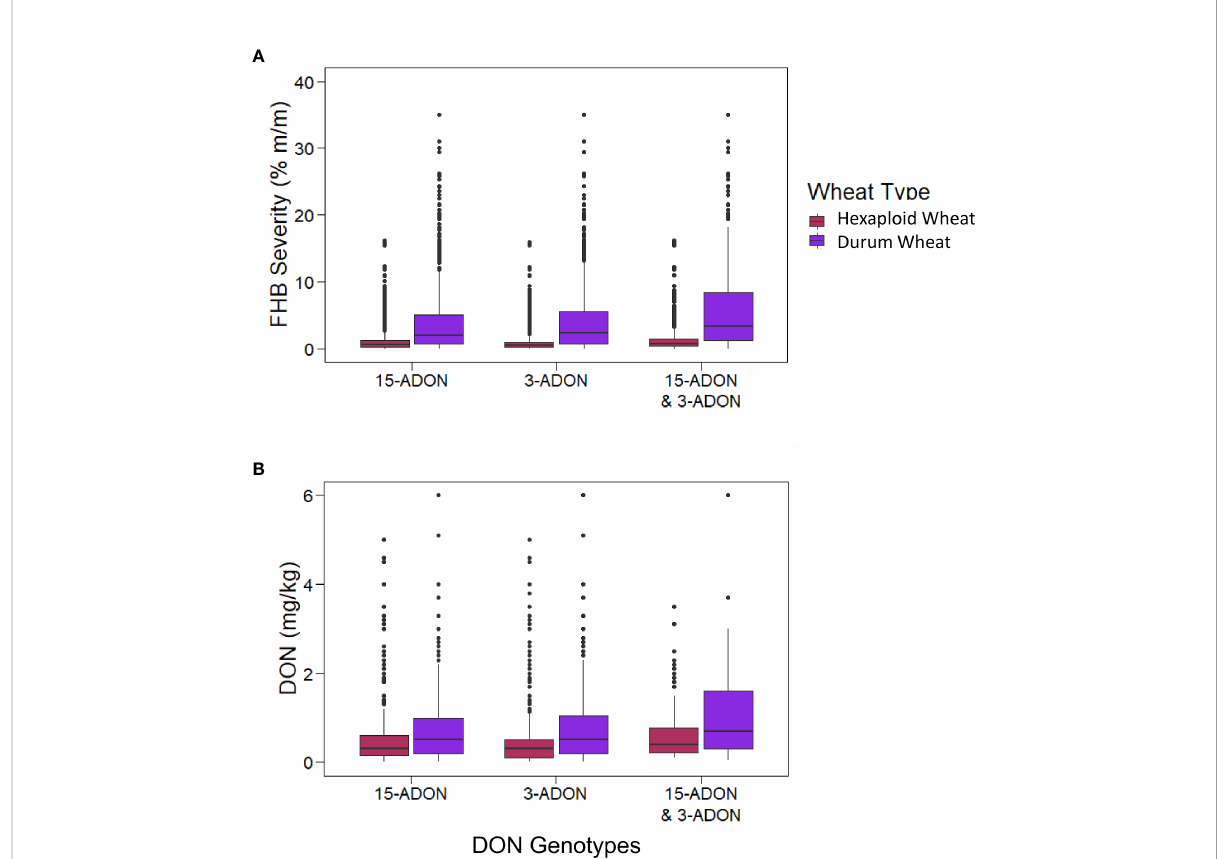
FIGURE 7 The FHB severity and DON levels for samples with kernels testing positive for different ADON genotypes. The boxes represent the interquartile range (IQR; 25% percentile, median, 75% percentile), the whiskers representing the highest and lowest values within the boundaries of 1.5 × IQR, and dots above the box and whisker plots signify outliers. (A) FHB severity (%) for samples containing kernels testing positive for either or both ADON genotypes. (B) DON (mg/kg) for samples containing kernels testing positive for either or both DON